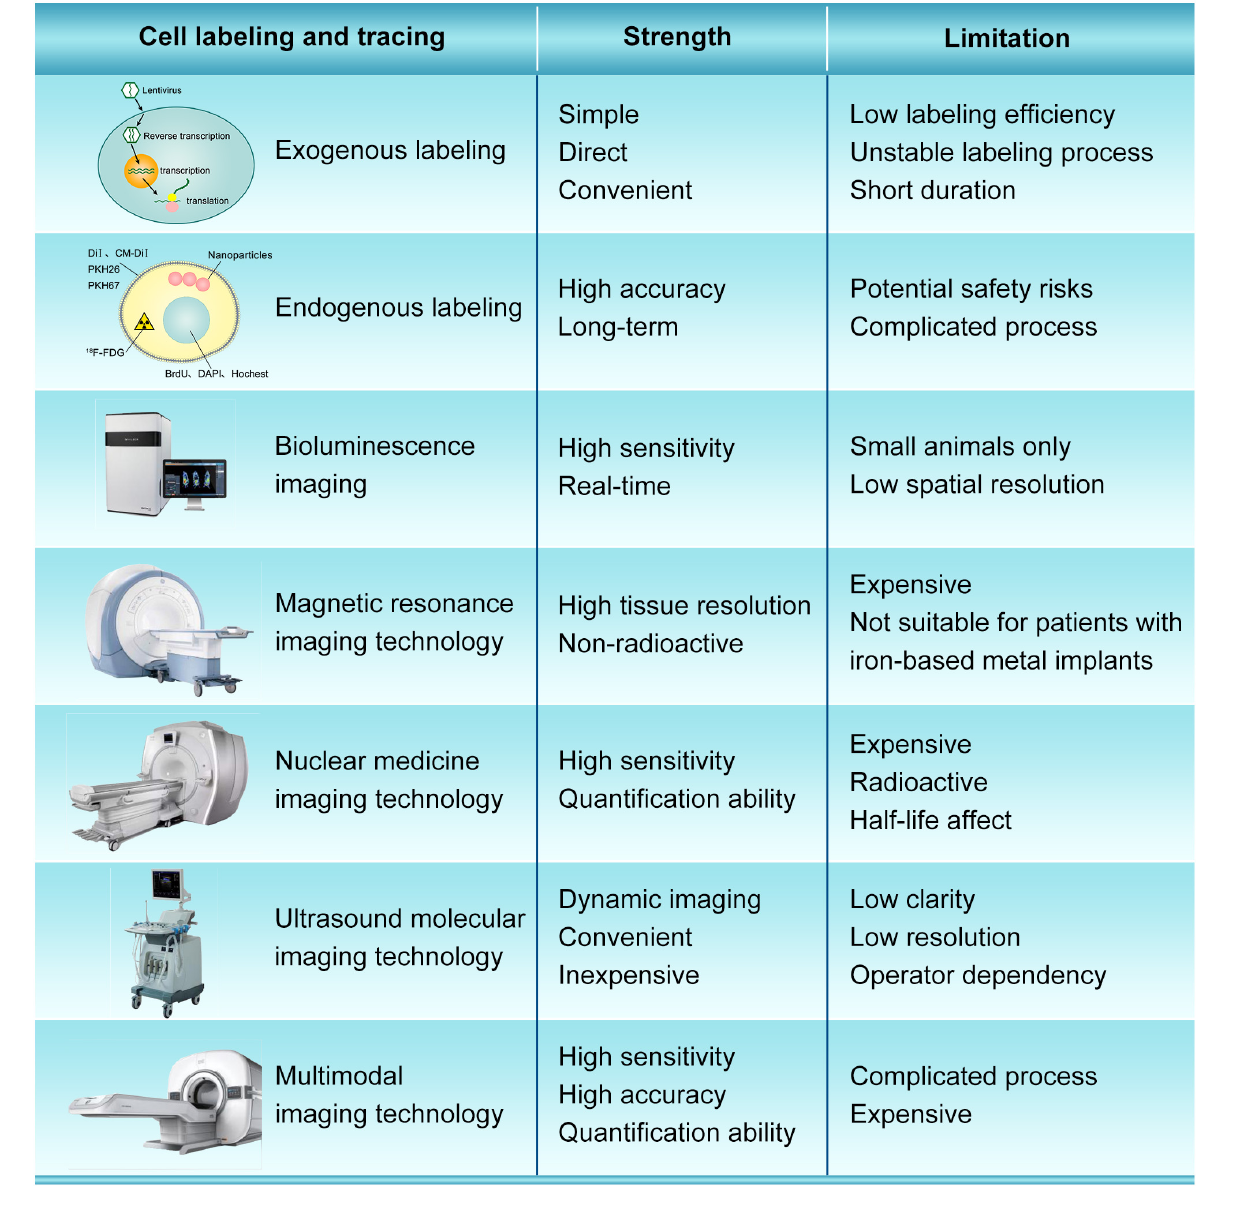
FIGURE 3 | The strength and limitation of different cell labeling and imaging